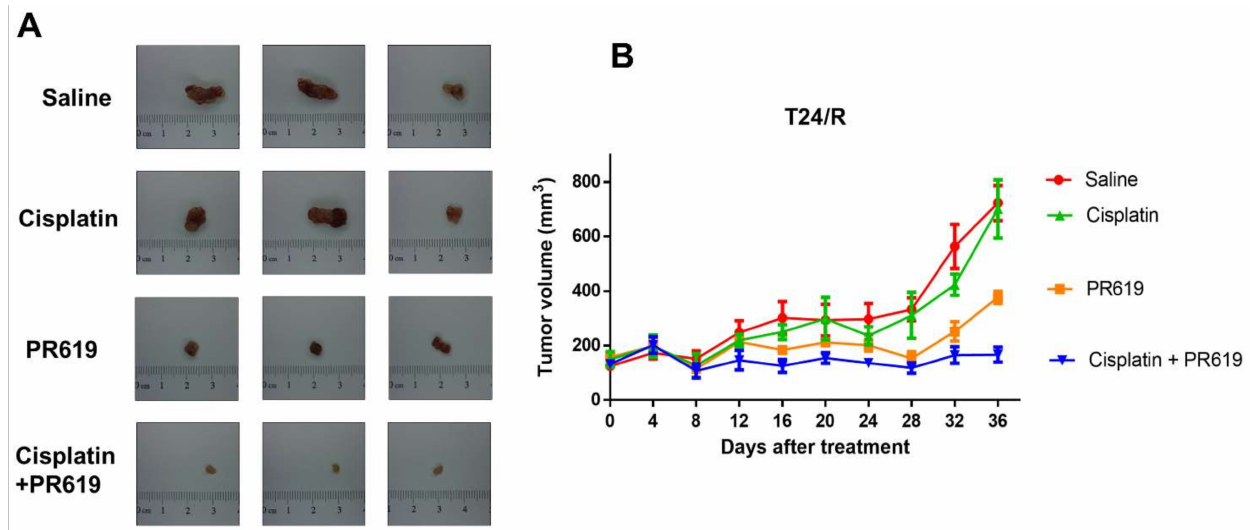
Figure 6. PR-619 enhances the antitumor effect of cisplatin in mice with xenografts of cisplatin-resistant urothelial carcinoma (UC) cells (T24/R). Nude mice with cisplatin-resistant T24/R UC xenograft tumors were treated with saline (untreated control, n = 5), cisplatin ( n = 6), PR-619 ( n = 7), or cisplatin/PR-619 combination ( n = 8) for 36 days. ( A ) The tumor images represent the excised tumors from each group. ( B ) Tumor volume of each group during the 36-day treatment period. The data are presented as means ± standard error of the